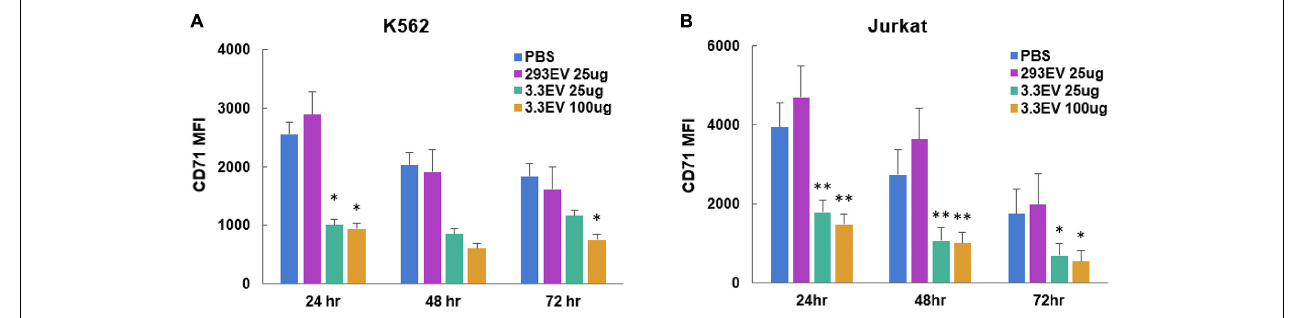
FIGURE 8 | Reduction in expression of leukemia cell proliferation marker CD71 in NK3.3 EV treated cells. (A) K562 and (B) Jurkat cells were treated with either PBS, 25 µ g/ml HEK293 EVs, 25 or 100 µ g/ml NK3.3 EVs, stained for proliferation marker CD71, and analyzed by flow cytometry. MFI: mean fluorescence intensity. Mean MFI ± SE; n = 3. p- Values determined by comparison of NK3.3 EV-treated cells to HEK293 EV-treated cells. ∗ p ≤ 0.05, ∗∗ p ≤ 0.005.